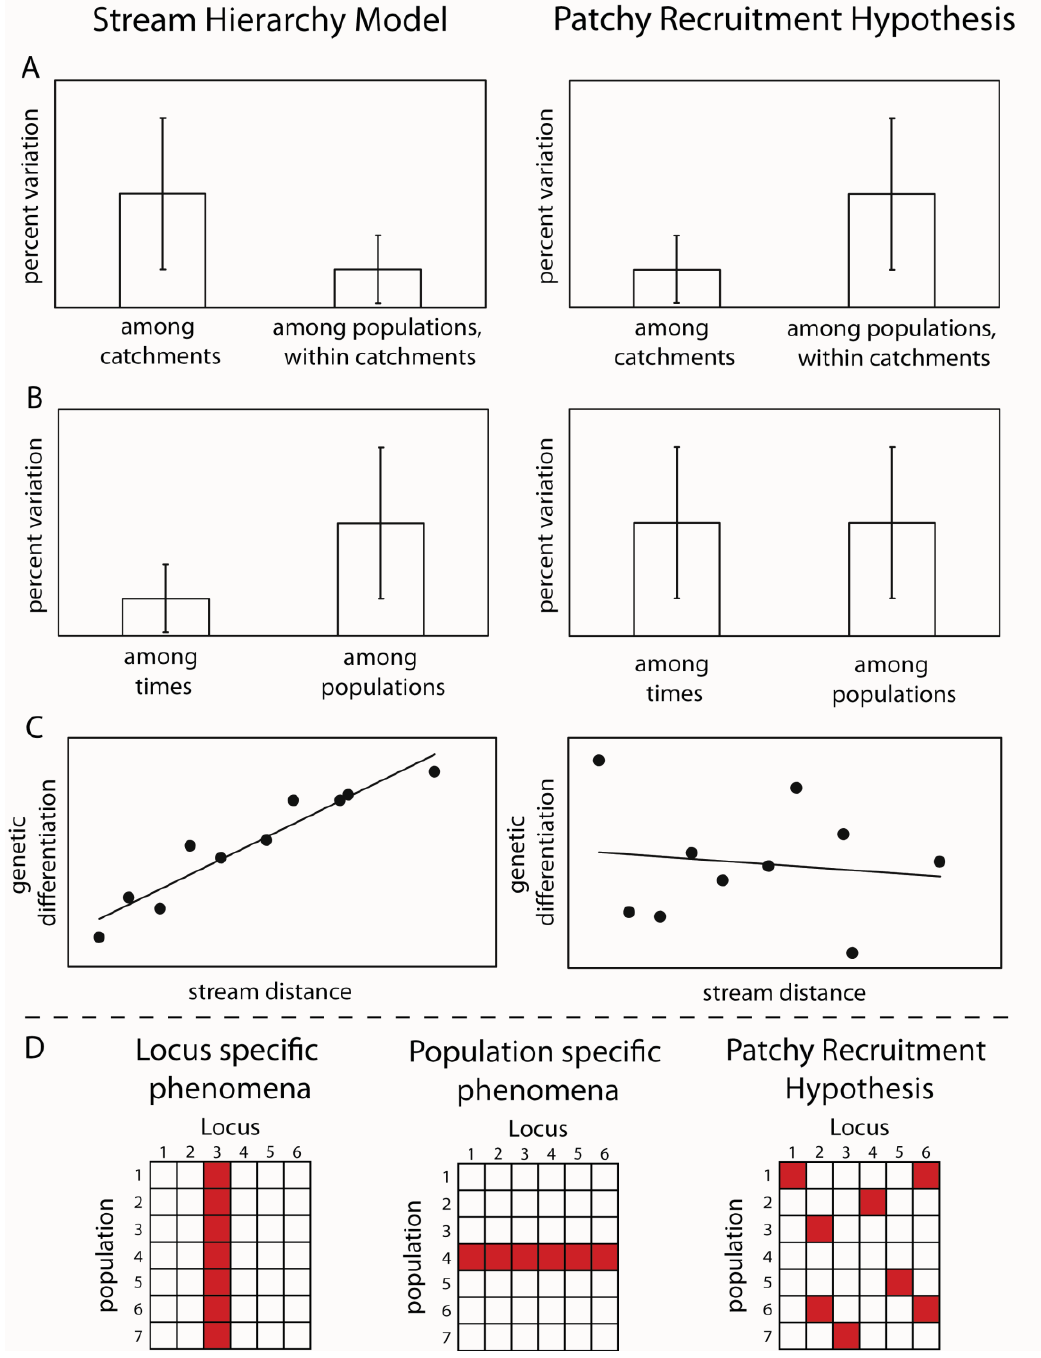
Figure 1. Predictions for population genetic variation under two contrasting demographic models; the Stream Hierarchy Model and the Patchy Recruitment Model ( A – C ); ( D ) Shows different interpretations of deviations from Hardy-Weinberg Equilibrium. Red squares indicate significant